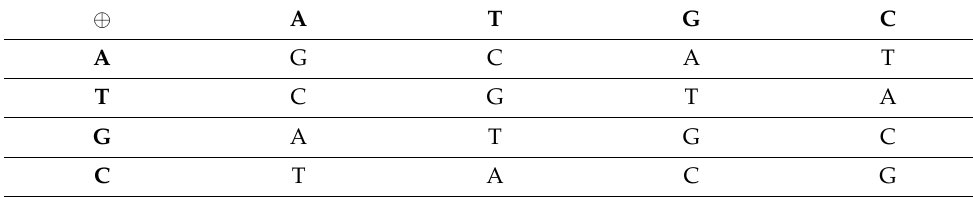
Table 4. Rule 3 for DNA